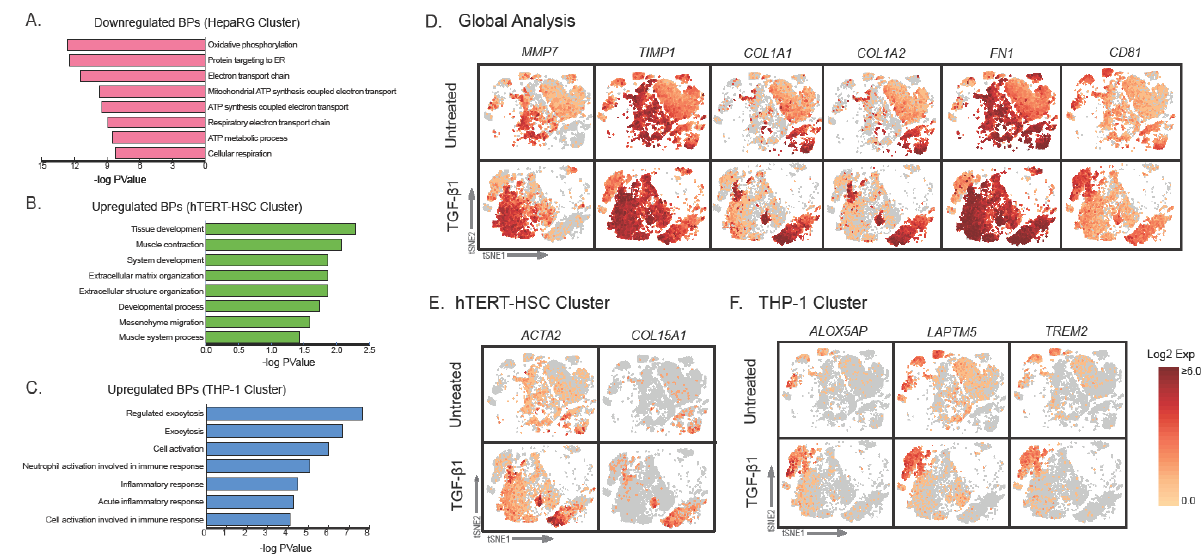
Figure 7. Visualization of fibrosis-relevant markers Specific effects on genes of interest are shown based on the scRNA-seq data to identify cell-specific responses. The responses of individual cell clusters (supervised method) to TGF- β 1 (1 ng/mL) treatment for 48 h were evaluated to identify treatment-related cell specific changes in gene expression. Significantly differentially expressed genes (LogFC p < 0.05) for each cell type were identified and using gProfiler to identify the corresponding biological pathways and expressed as − log ( p Value). A total of 48 significantly downregulated genes were identified for treated HepaRG ( A ), 25 significantly upregulated genes for hTERT-HSC ( B ) and 45 significantly upregulated for THP-1 ( C ). Graphs D–F represent expression changes of specific genes: Genes that were significantly regulated in the global TGF- β 1 treated sample vs. untreated ( D ) treated hTERT-HSC cluster vs. untreated hTERT-HSC cluster ( E ) and THP-1 cluster vs. untreated THP-1 cluster ( F ). Data are expressed as log2 expression (selected markers shown in tSNE